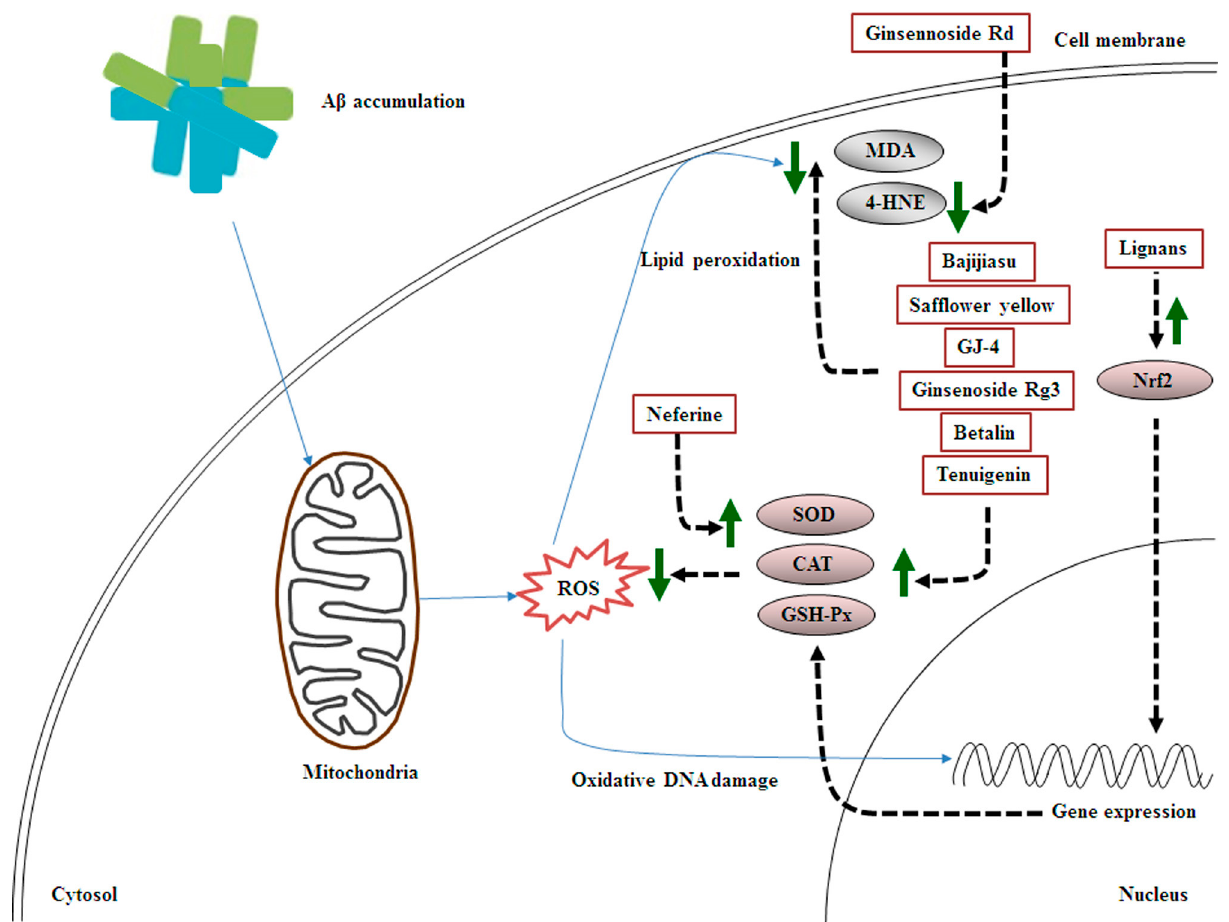
Figure 2. Schematic representation of the effects of MHDIs on A β -induced oxidative stress in the cortex and hippocampus in the early and late phases of AD in in vivo models.